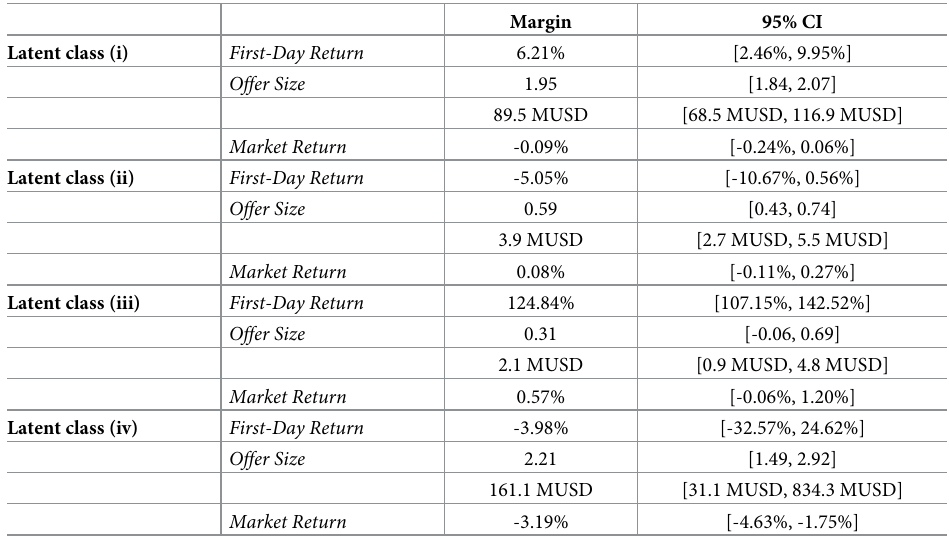
Table 5. Predicted latent class means using first-day returns on the issuing firms’